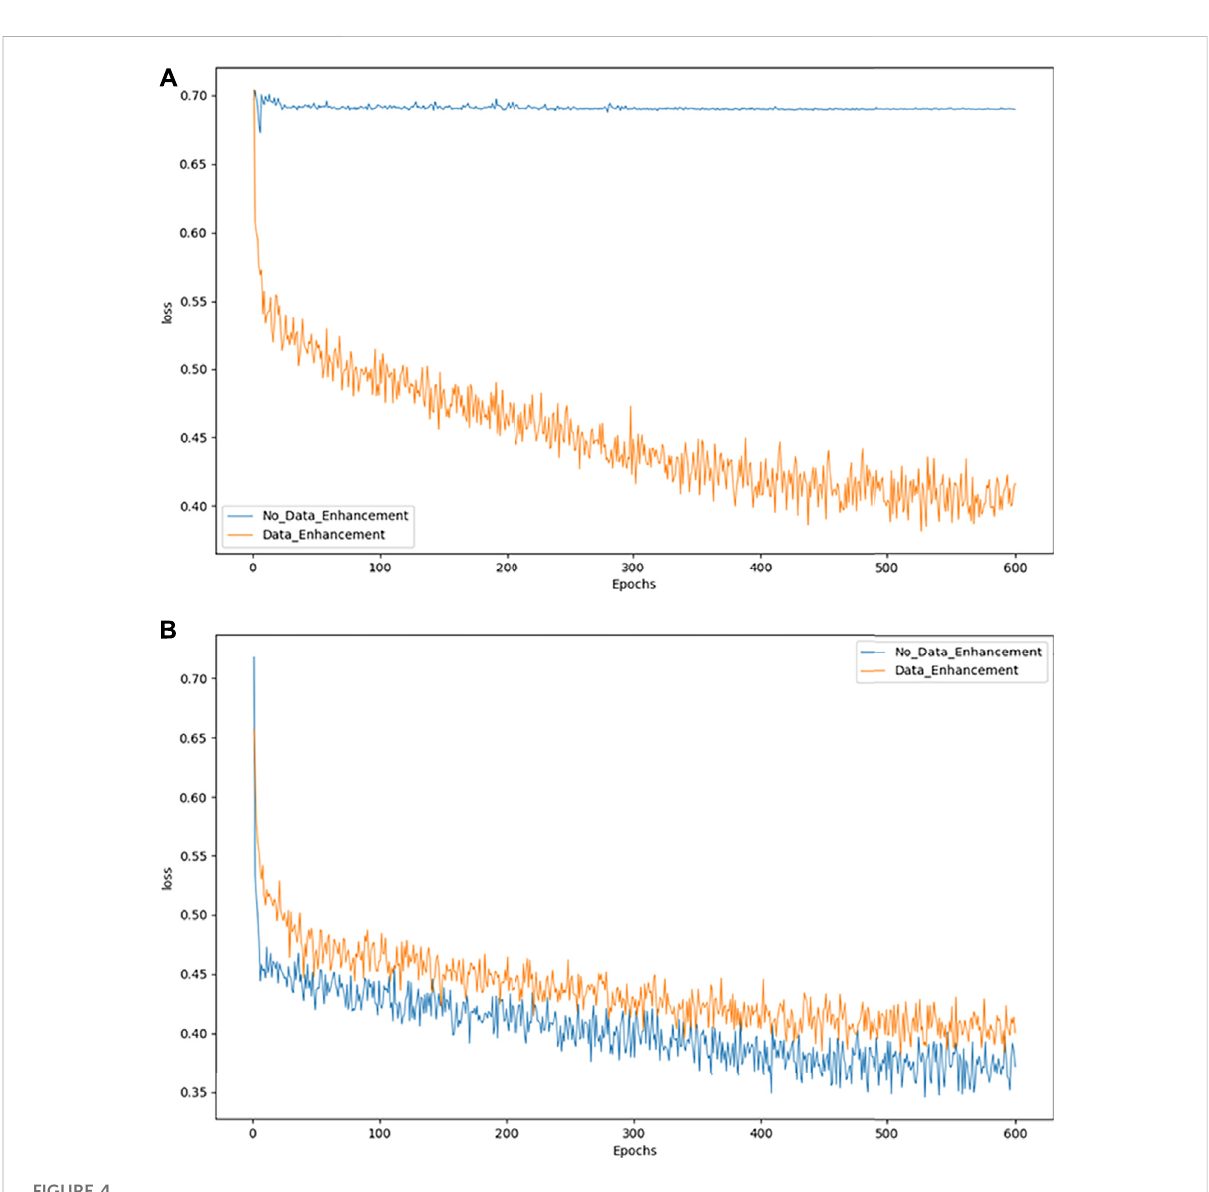
FIGURE 4 Model convergence performance of binary classi fi